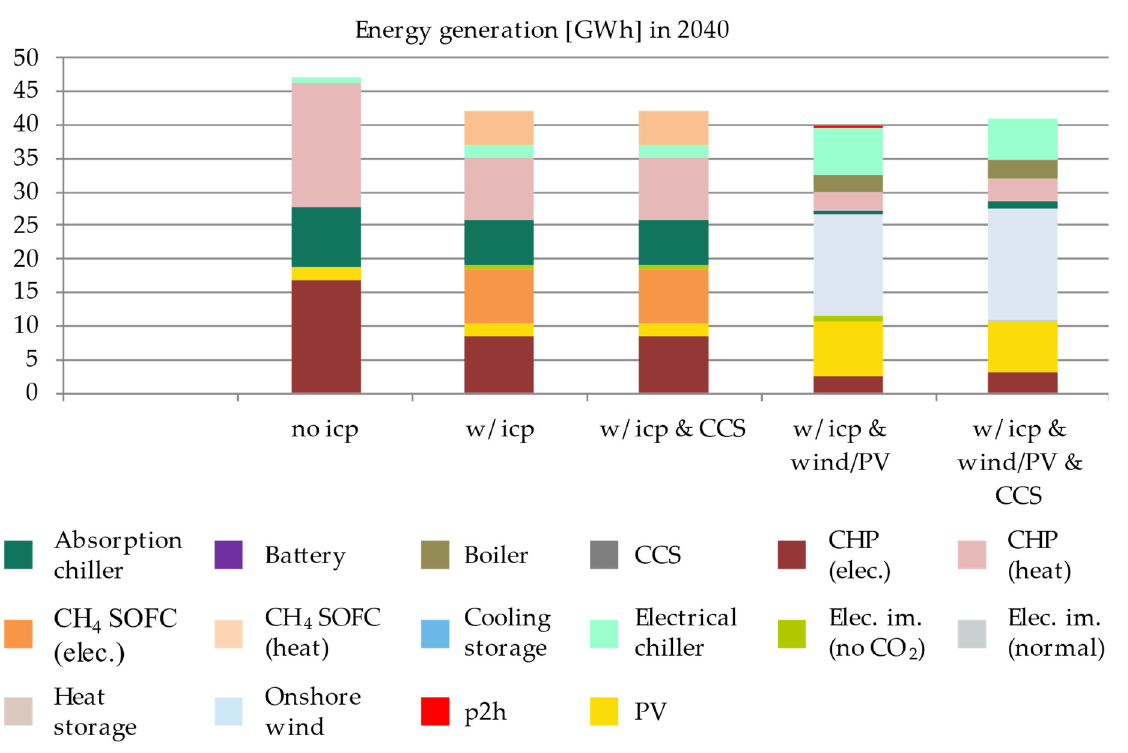
Figure 7. Installed capacities for the British scenarios in 2040.